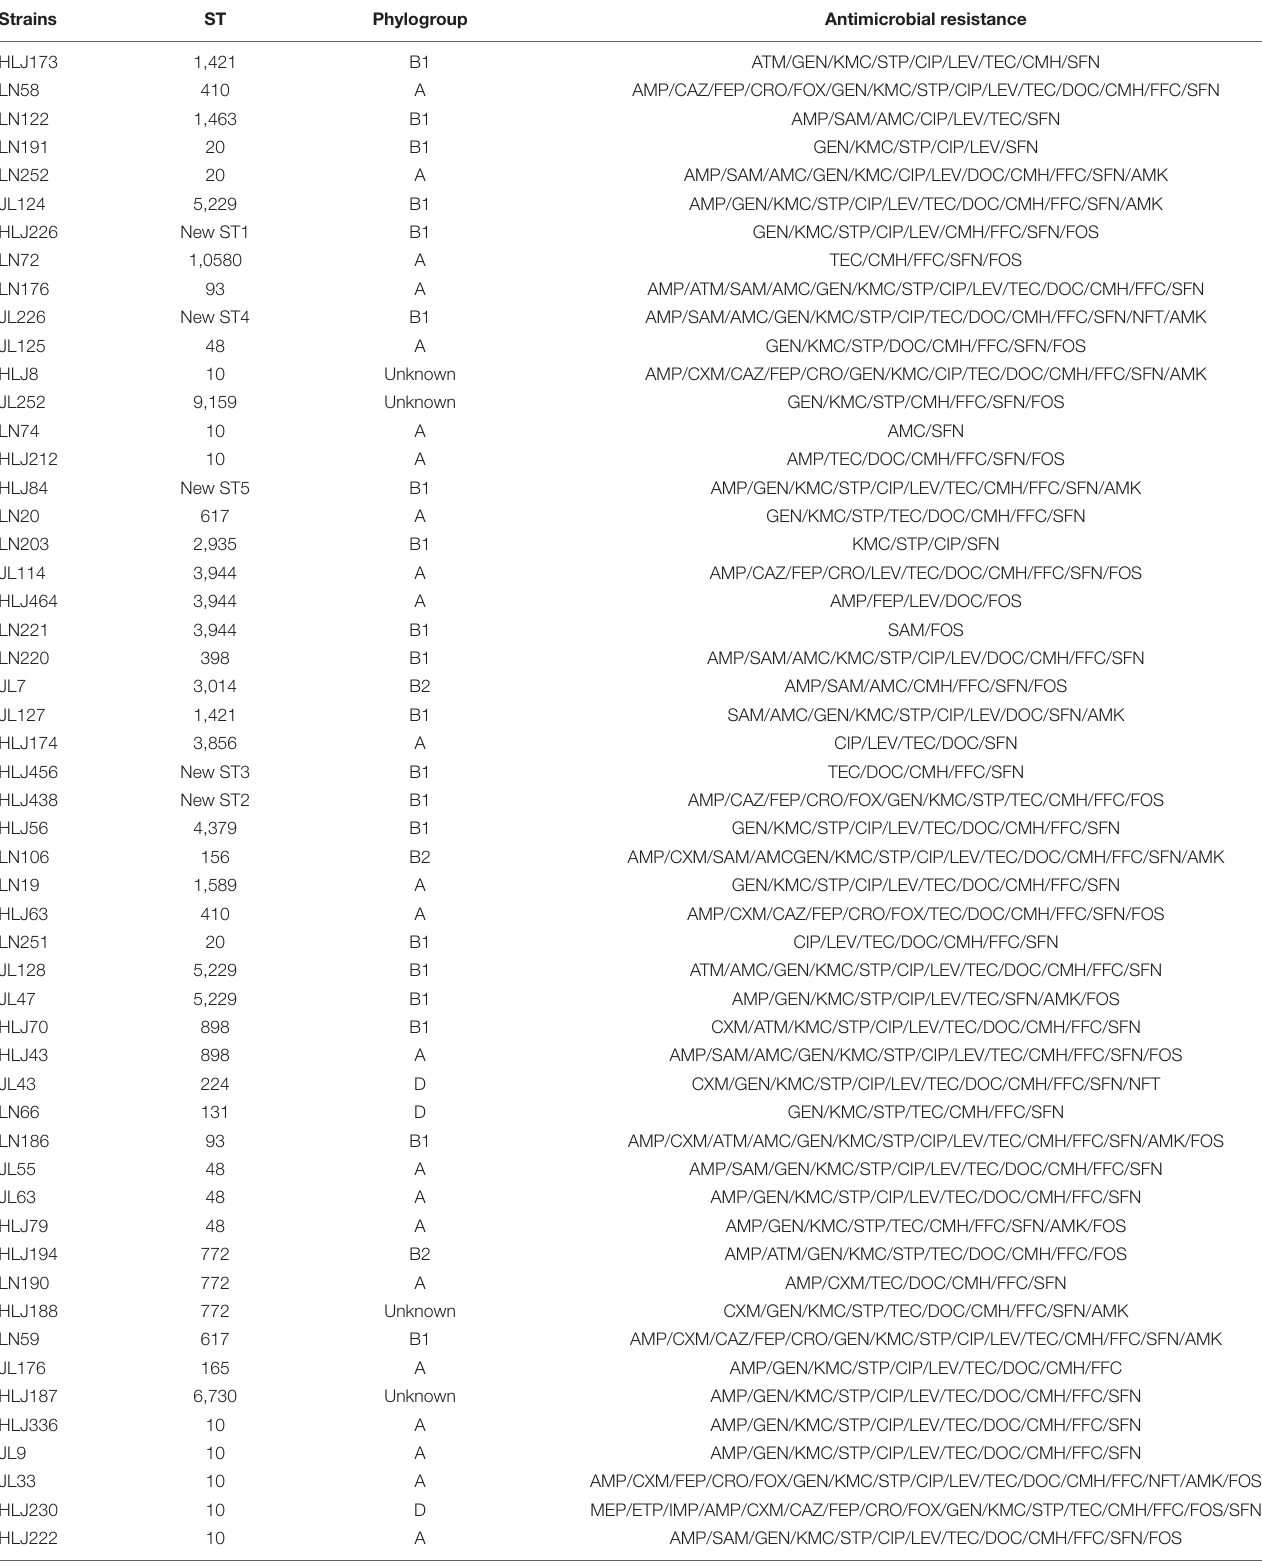
TABLE 1 | Characteristics and antimicrobial resistance profiles of mcr-1 -positive E. coli. Strains ST Phylogroup Antimicrobial